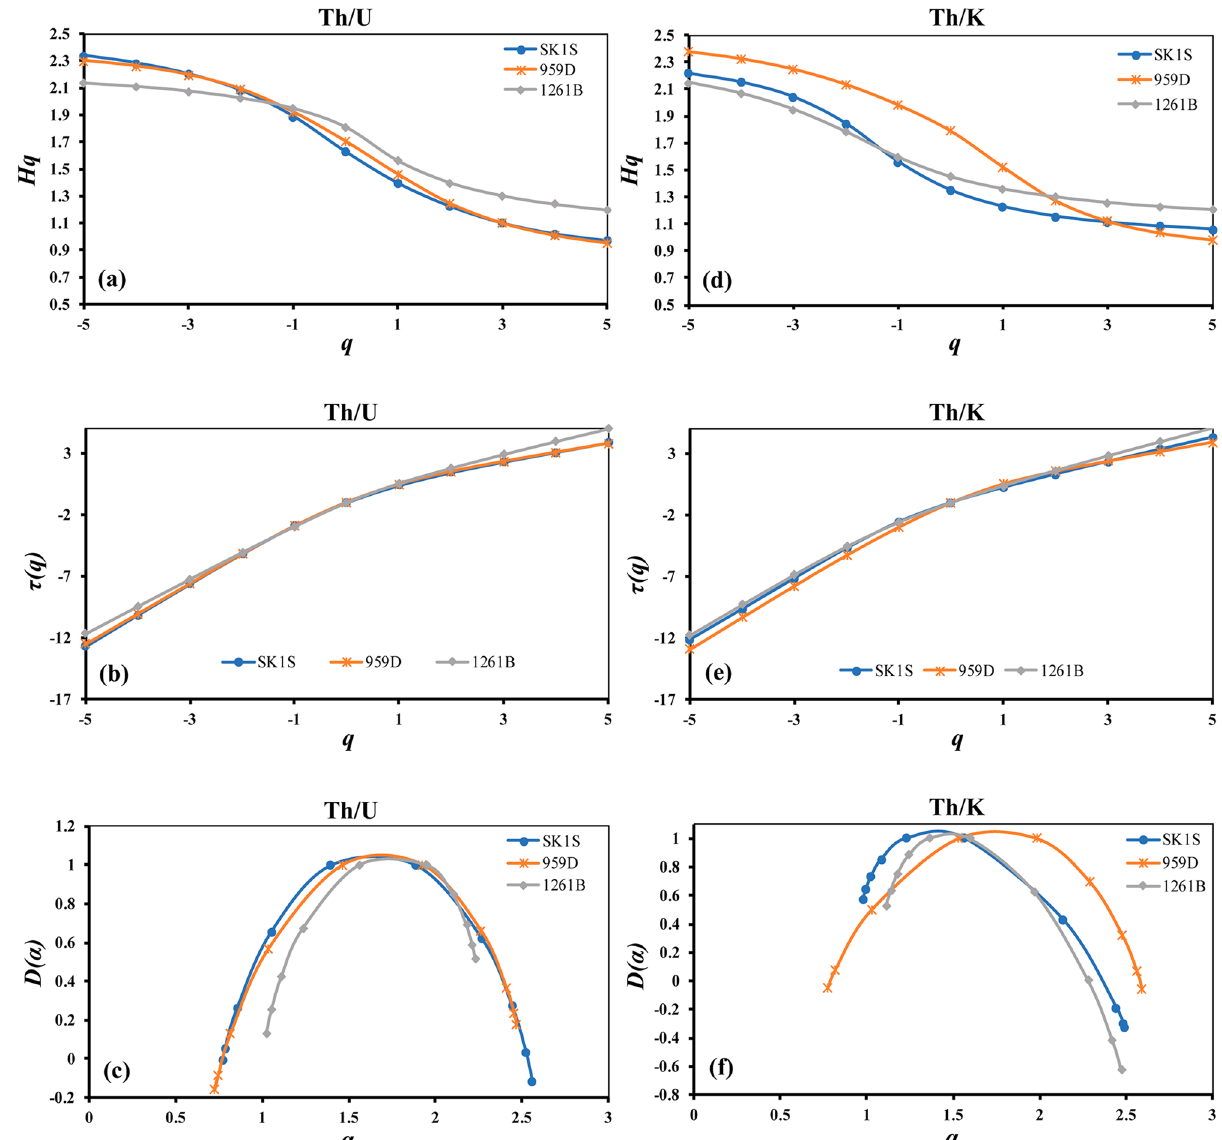
Figure 5. The Multifractal properties of the thorium–potassium and thorium–uranium distributions in the studied OAE3 intervals recorded in Songliao Basin (SK1S), Deep Ivorian Basin (959D) and Demerara Rise (1261B). ( a ) The generalized Hurst exponents of the Th/U ratio. ( b ) The mass exponents of the Th/U ratio. ( c ) The multifractal spectrum of the Th/U ratio. ( d ) The generalized Hurst exponents of the Th/K ratio. ( e ) The mass exponent of the Th/K ratio. ( f ) The multifractal spectrum of the Th/K